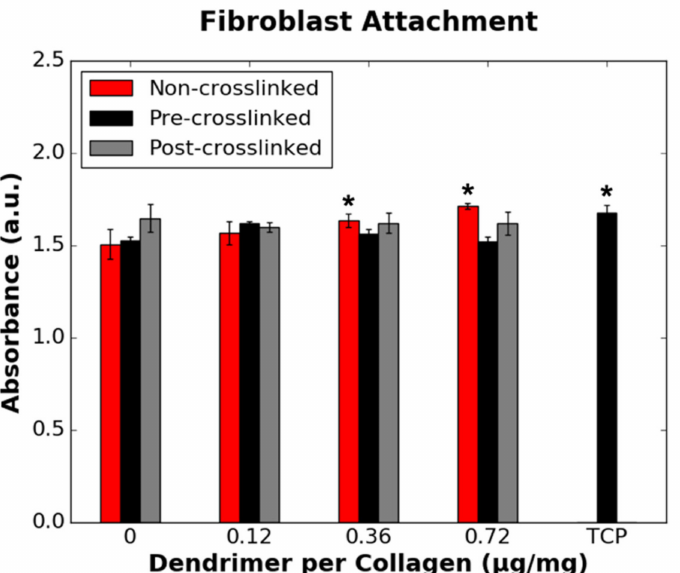
Figure 5. Effect of the quantity of IKVAV-capped dendrimers added to the various collagen films on HDF binding. HDFs were seeded onto non-collagen coated wells (TCP controls) on the same 48-well plate as pre-crosslinked films. * denotes statistically significant difference ( p ≤ 0.05) between the data point annotated and the respective 0 µ g/mg value for each collagen